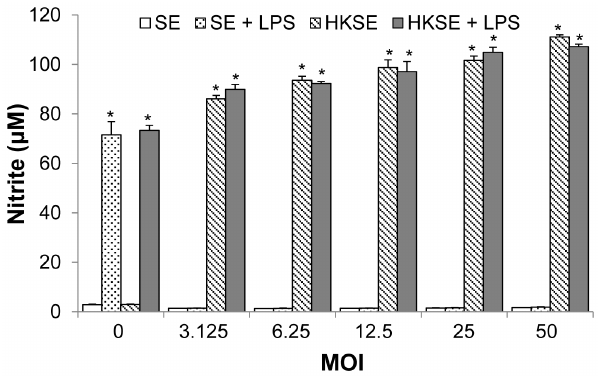
Figure 2. Effect of S . Enteritidis infection on nitric oxide (NO) production in HD11 cells. HD11 cells were infected with live S. Enteritidis (SE) for 1 h in 24-well plates at 39 u C in a 5% CO2 humidified incubator. At 1 hour post infection (hpi), extracellular SE were killed by incubation with media containing 100 m g/mL of gentamicin sulfate for 1 h; the cells were washed and then cultured with or without lipopolysaccharide (LPS) at 0.2 m g/mL for an additional 22 h in a medium containing 20 m g/mL of gentamicin sulfate; and nitrite contents in cell culture media were determined. Treatment with heat- killed S . Enteritidis (HKSE) was performed identically as with live SE. The symbol (*) indicates that the difference between these groups and the control is statistically significant (p ,